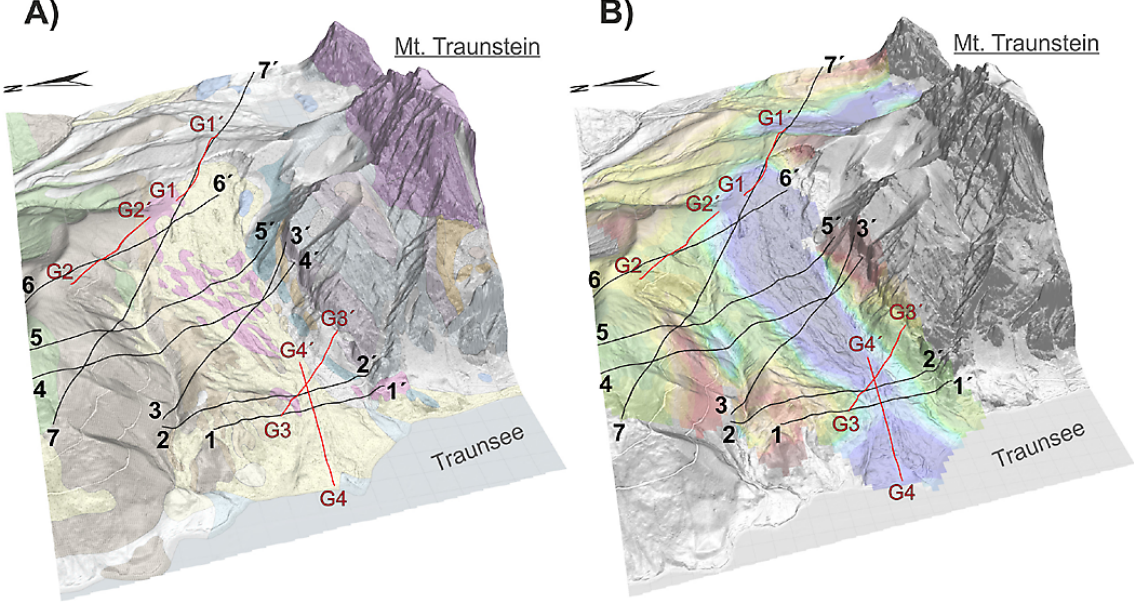
Fig. 9. 3-D view of the geological (A) and electromagnetic (B) map seen from the west; black lines: locations of the HEM cross sections; red lines: locations of the geoelectric